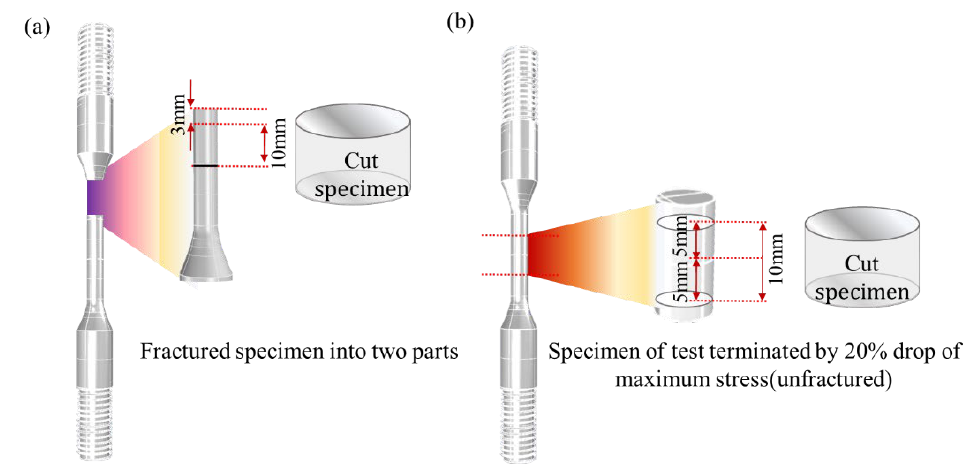
Figure 3. Schematic of cut specimen for microstructure analysis: ( a ) specimen separated into two parts; ( b ) unfractured specimen.